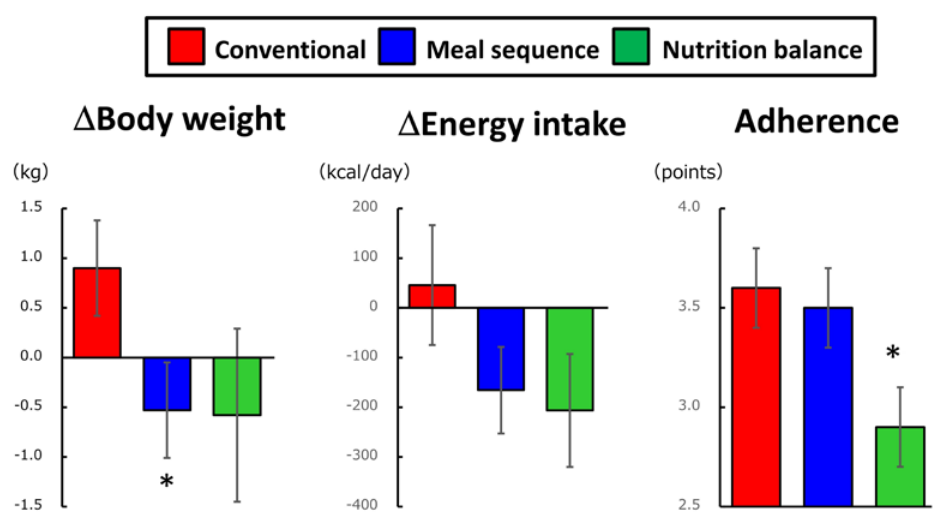
Figure 3. Dietary intervention focusing on meal sequence suppressed energy intake and reduced body weight in individuals with prediabetes. E ff ects of dietary instruction focusing on meal sequence (Meal sequence, n = 18) were compared to conventional dietary instruction (Conventional, n = 11) and dietary instruction focusing on nutritional balance (Nutrition balance, n = 13) using SMART Washoku ® (Kao Corporation, Tokyo, Japan), which can help individuals consume a more nutritionally balanced diet, in an exploratory, cluster-randomized, prospective, open-label, clinical trial [30]. Each participant reported adherence to their goals for diet and healthy exercise every month using a scale of 1–5, where 1 indicated “seldom adhered” and 5 indicated “fully adhered”. The group receiving dietary instruction focusing on meal sequence exhibited similar adherence and greater reduction in body weight than the group receiving conventional health guidance, while the group receiving dietary instructions focusing on nutritional balance failed to show significant body weight reduction, partly due to poor adherence. Mean ± SEM; *, p < 0.05 versus conventional and p < 0.05 versus meal